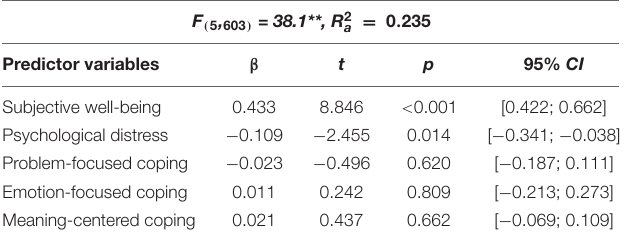
TABLE 3 | Predictive regression model for subjective perception of health of participants ( n = 604).